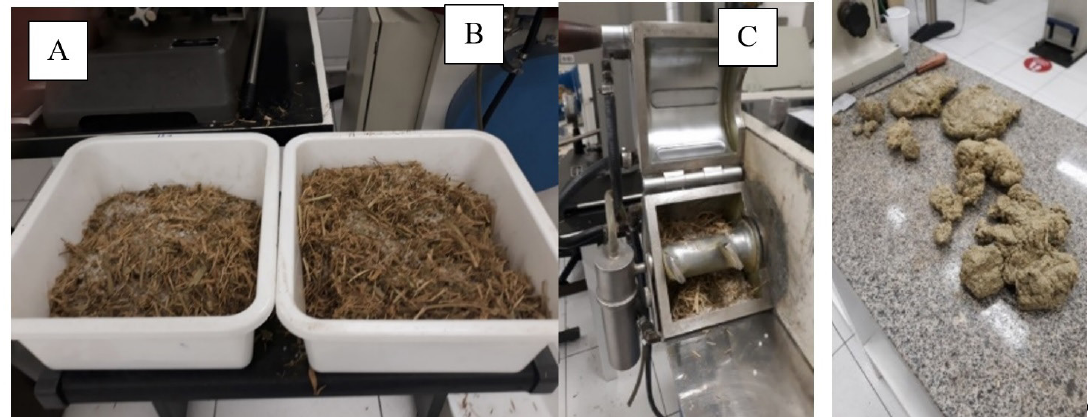
Figure 2. PP/fiber blends (A), high-speed mixer (B) and PP/fiber composite obtained in the high-speed mixer (C).